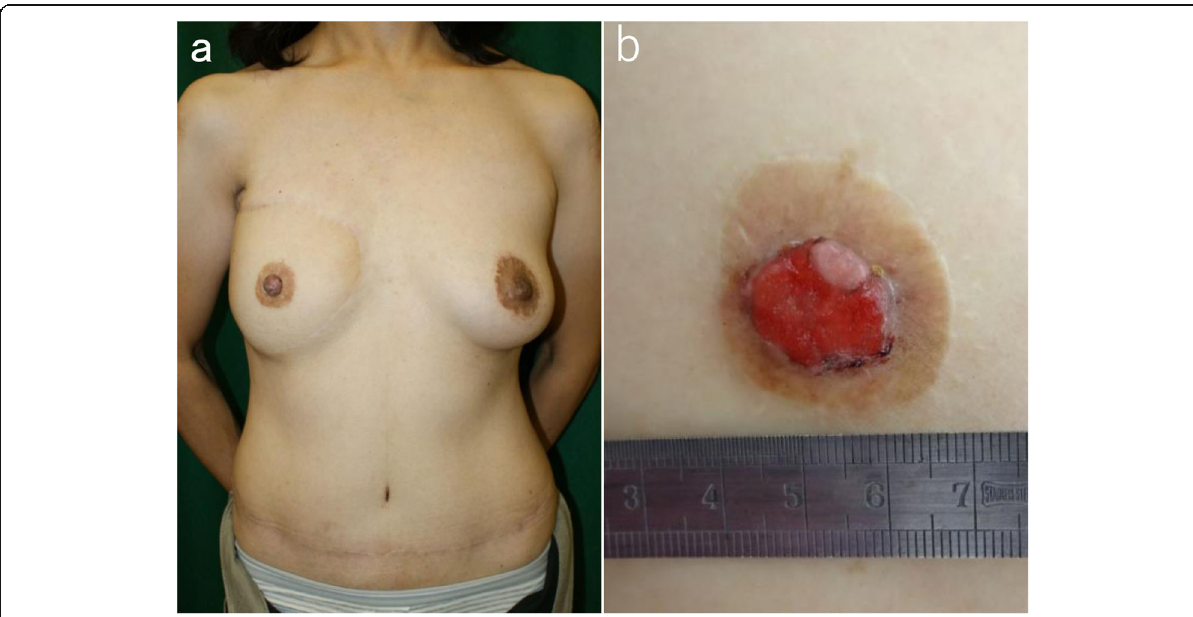
Fig. 1 a This is an image obtained about 6 months after autologous breast reconstruction (ABR) with a deep inferior epigastric perforator (DIEP) flap, followed by nipple-areola complex (NAC) reconstruction of the right breast. b Image of the right NAC shows erosion and marginal crusting, with a small amount of normal tissue at the upper right side of the grafted nipple. The erosion was hemorrhagic on scraping. The grafted areola